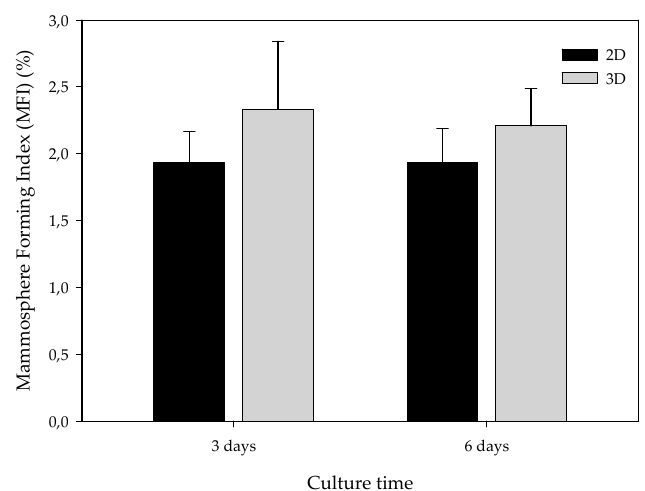
Figure 6. Mammosphere-forming Index (MFI) of MDA-MB-231 TNBC cells after monolayer (2D) or 15% PLA scaffolds (3D) culture. Experiments were performed at least three times.